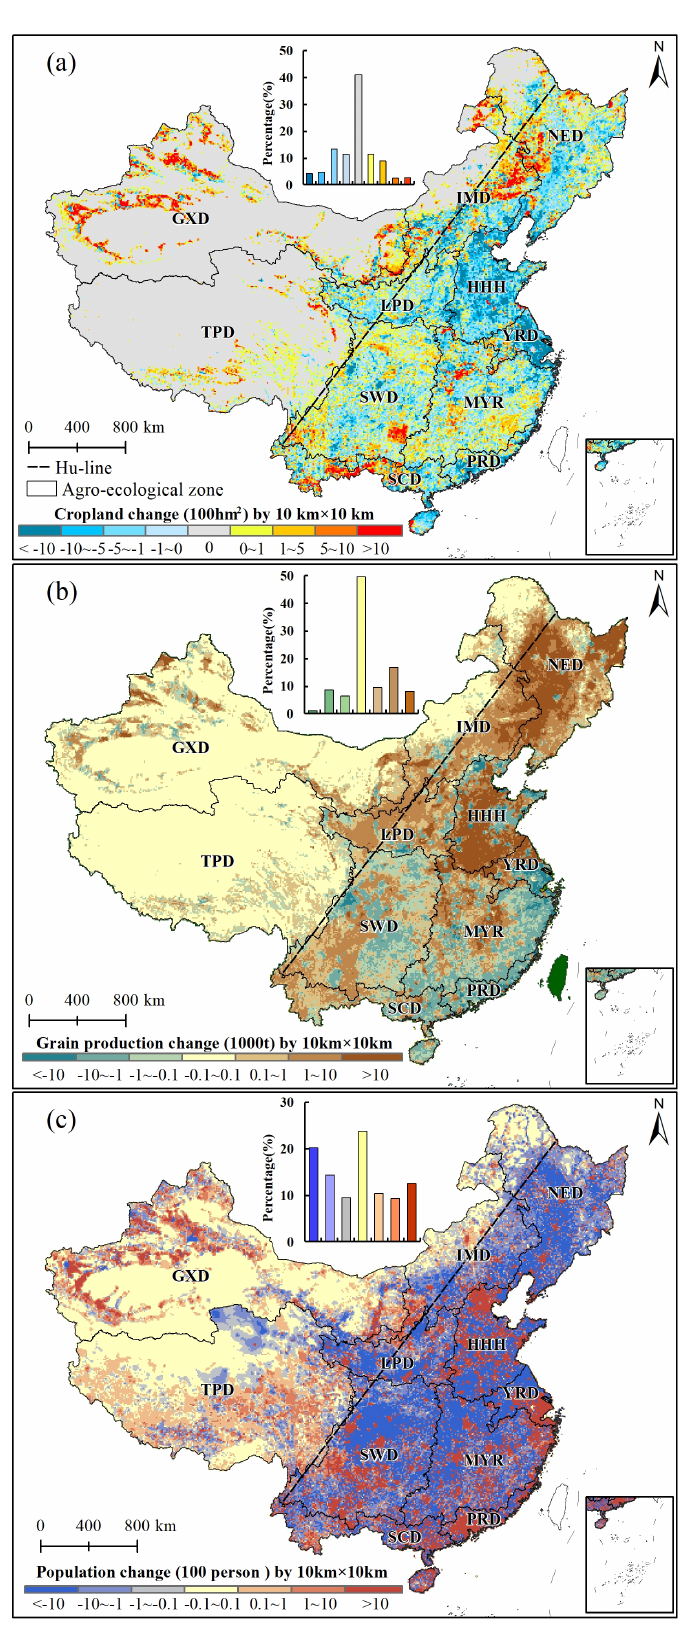
Figure 2. Spatial pattern of changes in cropland area ( a ), grain production ( b ), and population ( c ) in China over the past two decades.